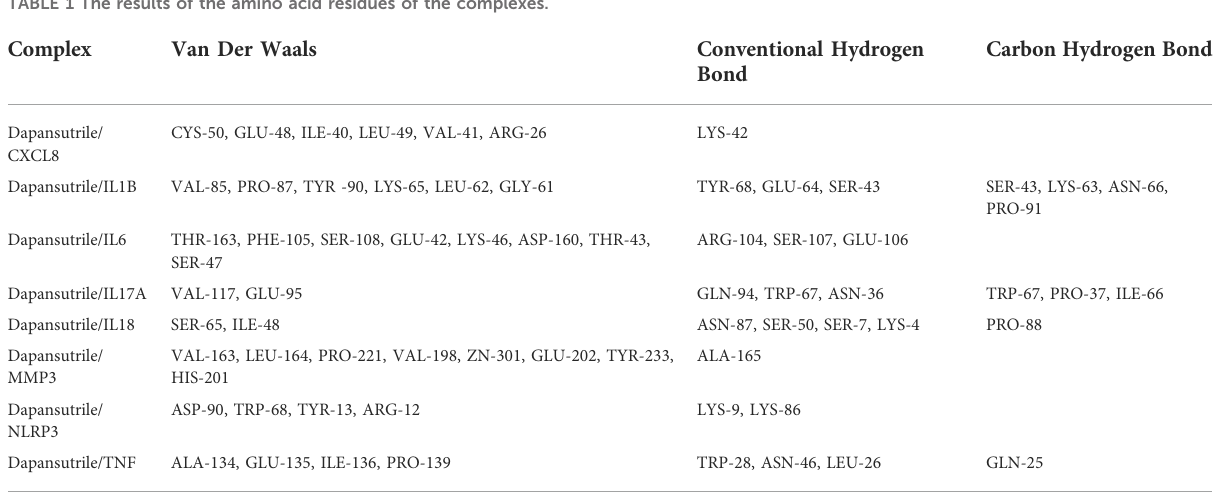
TABLE 1 The results of the amino acid residues of the complexes.